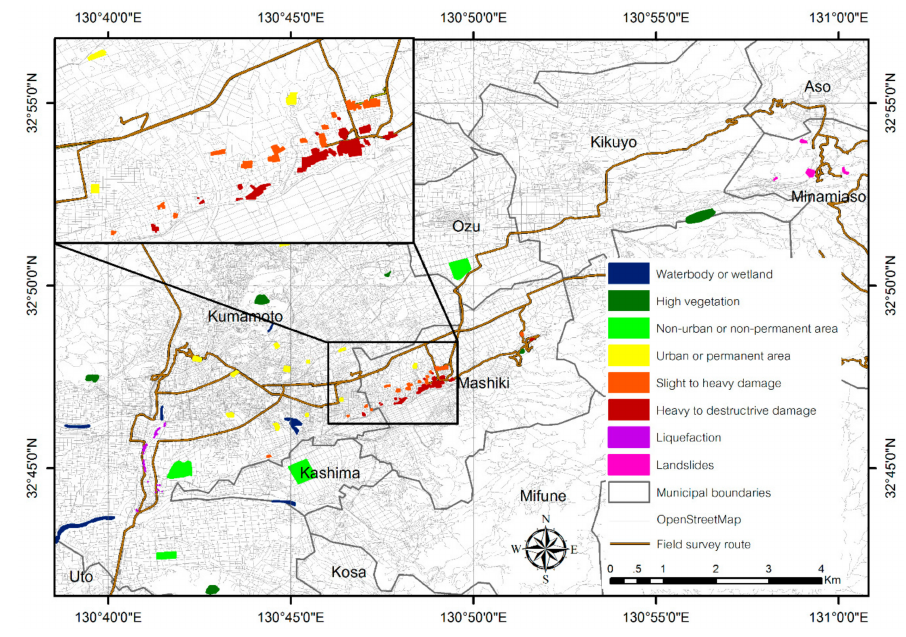
Figure 4. Ground truth map for accuracy